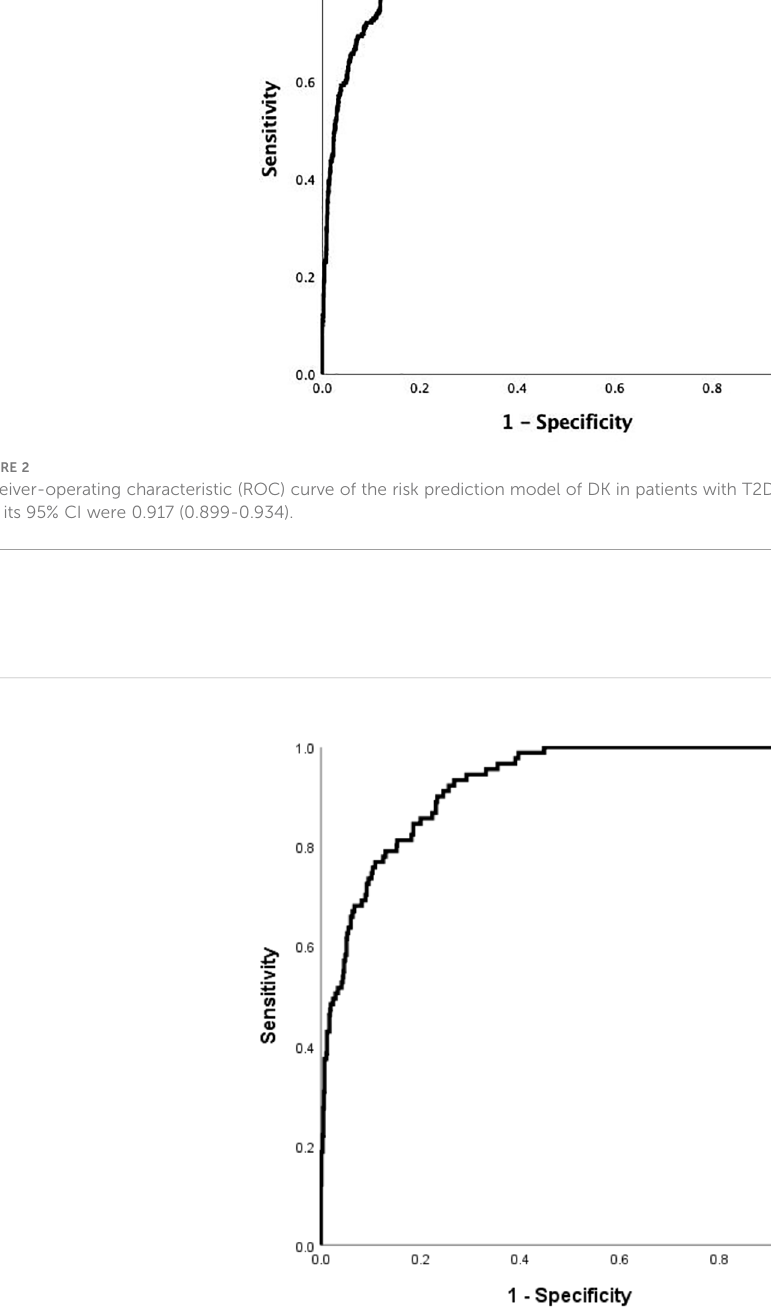
FIGURE 3 The performance of the DK in patients with T2DM risk prediction model in the validation cohorts. Receiver operating characteristic curve for the DKD risk prediction model. The AUC and its 95% CI were 0.922 (0.898-0.946).